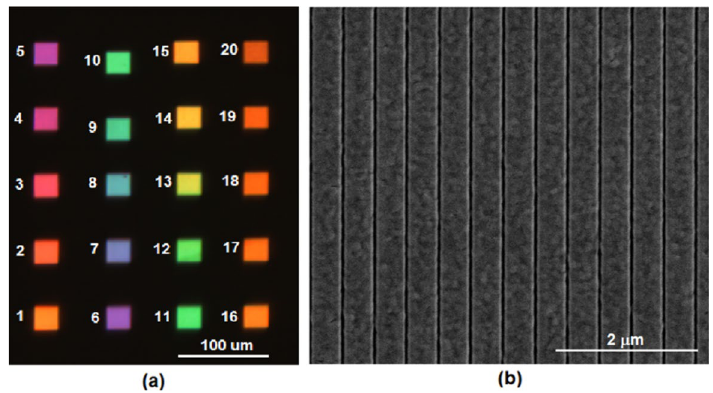
Figure 3. ( a ) RGB image of filter array with annotated filter numbers and ( b ) SEM image of a section of one of the filters.